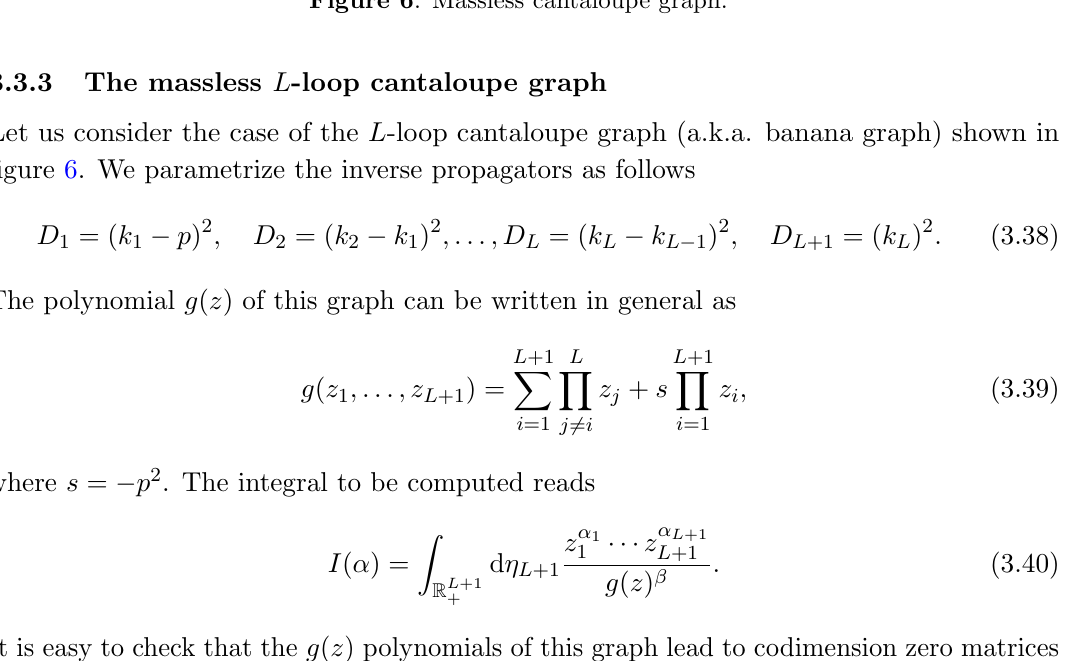
Figure 6 . Massless cantaloupe